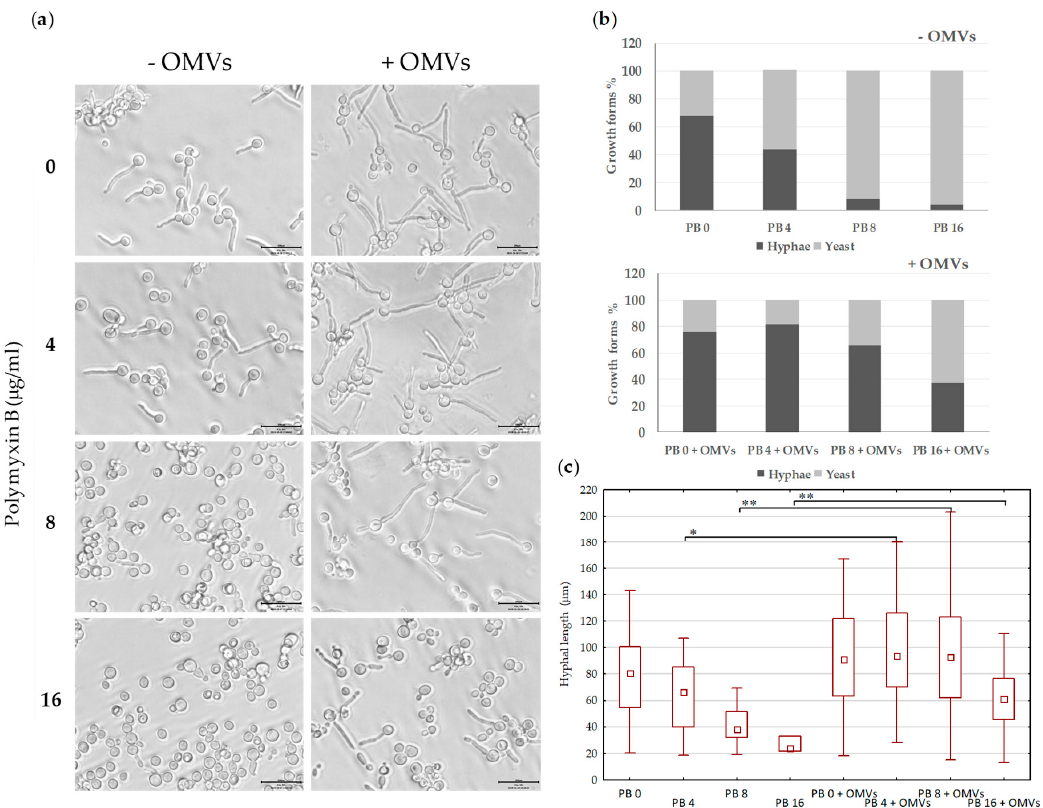
Figure 4. E ff ect of OMVs on filamentous growth of C. albicans : Yeast cells were preincubated overnight with 1 / 16 MIC of FLC (0.0625 µ g / mL) without shaking and then, after washing, were incubated at OD = 0.4 in 0.4 mL of hyphae inducing medium (10% FBS in PBS) in 24-well microtiter plates with shaking (130 rpm) for 2 h at 37 ◦ C in the presence of 0.0625 µ g / mL FLC, indicated concentrations of PB, and with or without 20 µ g / mL of OMVs. Three independent experiments were performed. ( a ) The filamentation was monitored under inverted microscope using 40 × objective (Zeiss) and images were recorded. Scale bars = 100 µ m. ( b ) The number of hyphal cells versus yeast cells was determined using ImageJ software. The pool of yeast cells contains yeasts and yeasts whose germ tubes did not exceed 10 µ m. The data represent the mean values calculated for ≥ 200 cells for each of the eight tested options. ( c ) Box and Whisker plots of hyphal length: Minimal and maximal values, median, quartiles Q 1 and Q 3 . Statistical analysis was performed by one-way ANOVA (* p < 0.05, ** p < 0.01).